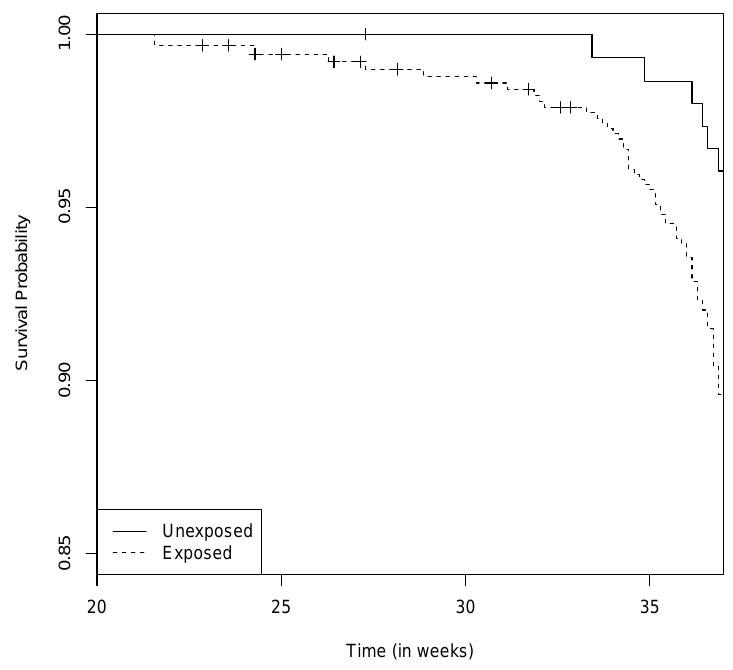
Figure 2. Enrollment ( i.e. , left truncation) time in gestational age from the pH1N1 vaccine